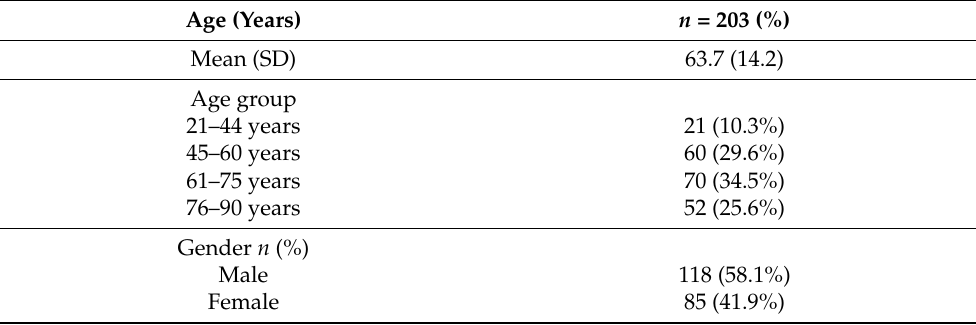
Table 1. Distribution of patients in relation to demographic data and